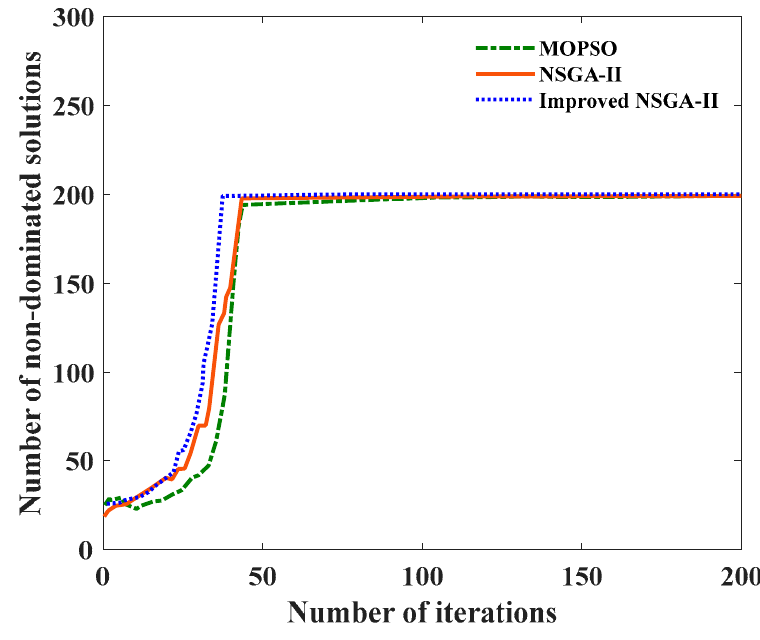
Figure 4. Iterative history of non-dominated solutions.